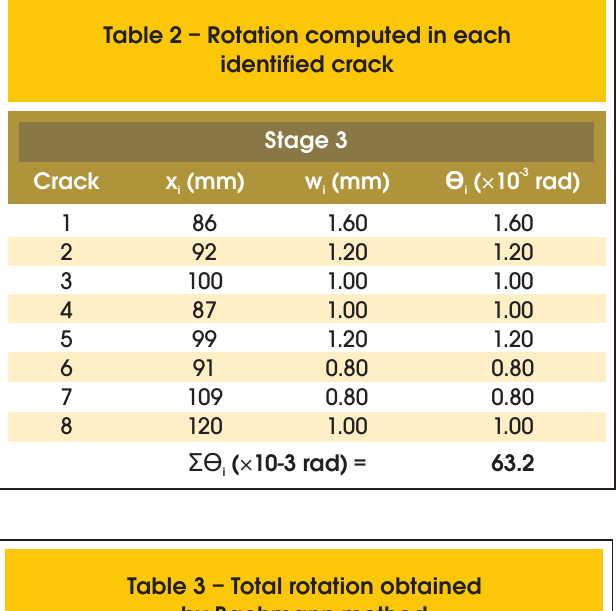
Figure 14 – Flexural stiffness vs. applied load